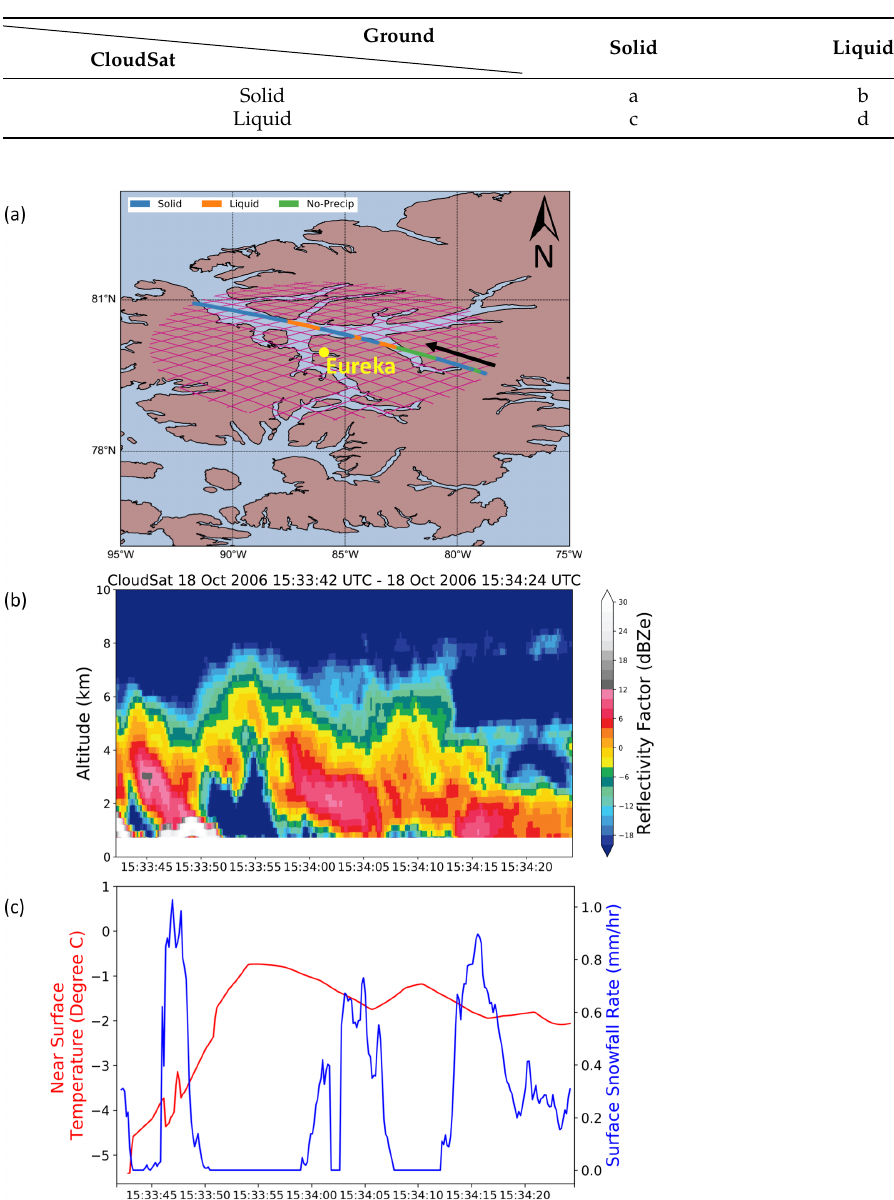
Table 2. Legend for comparing CloudSat and ground observations. In this example, a and d refer to the frequency of correct classification by CloudSat for solid and liquid precipitation, respectively. b refers to misclassification where the ground observation was liquid, but CloudSat classified solid precipitation and c is the reverse. A similar table (not shown) is used for precipitating and non- precipitating events.